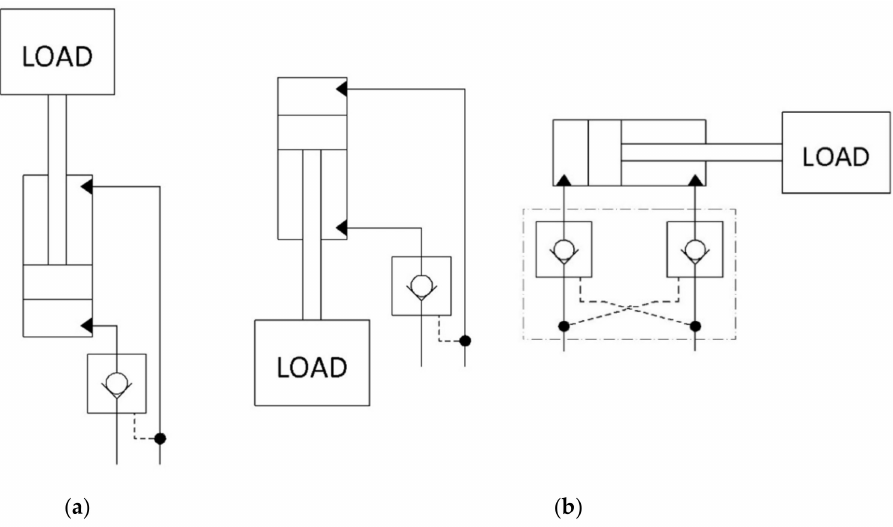
Figure 12. Pilot-operated check valve (POCV) application: ( a ) active load; ( b ) passive